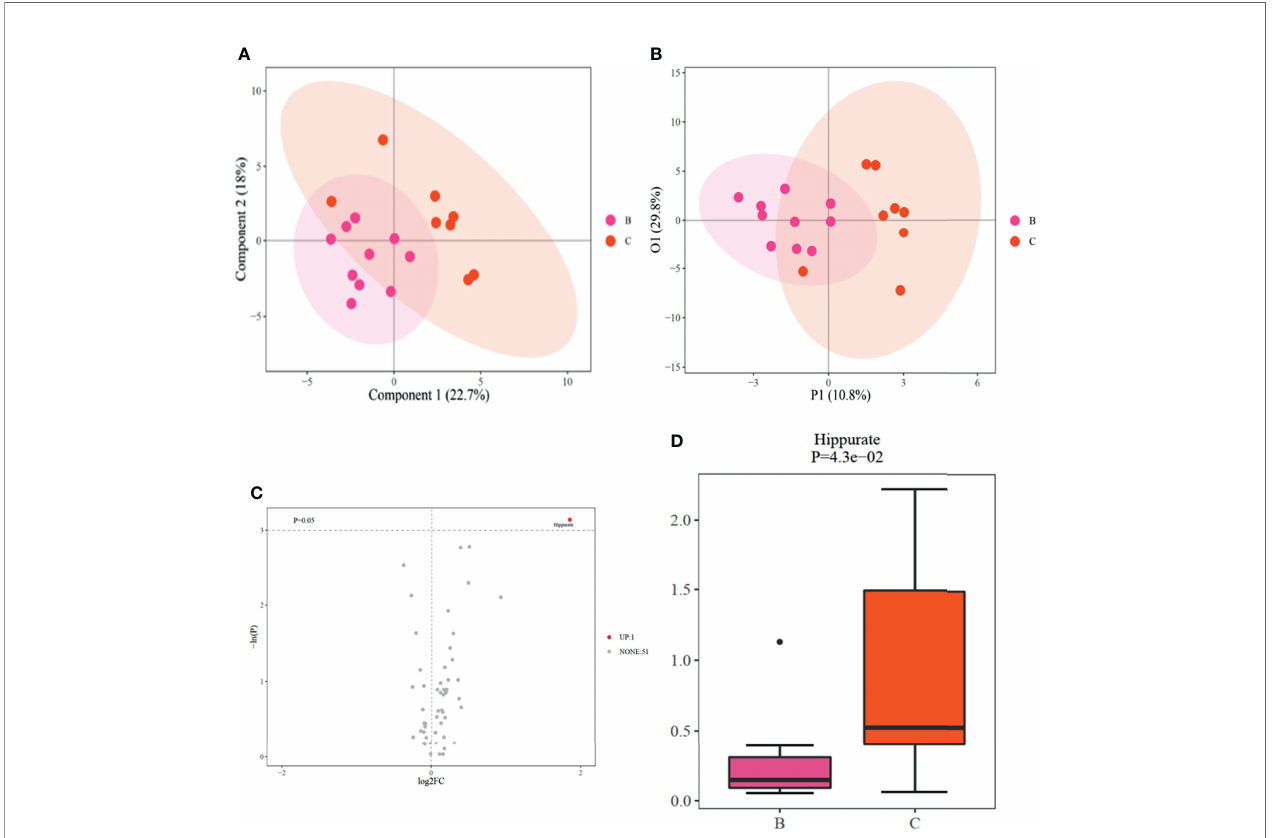
FIGURE 2 | (A). PLSDA scores between OSA non-remission and remission groups at baseline; (B) . OPLS-DA scores between OSA non-remission and remission groups at baseline; (C) . Volcano plot of differential metabolites generated by univariate analysis between OSA non-remission and remission groups at baseline. UP indicates that the level of the metabolite (hippurate) was higher in the OSA non-remission group than the OSA remission group before RYGB surgery. NONE indicates 51 metabolites with no signi fi cant difference between the OSA remission and non-remission groups before RYGB surgery; (D) . Boxplot of hippurate generated by univariate analysis compared between OSA non-remission and remission groups. (B) indicates the OSA remission group and (C) indicates the OSA non-remission group. PLS-DA, partial least squares-discriminant analysis; OPLS-DA, orthogonal partial least squares-discriminant analysis; OSA, obstructive sleep apnea; RYGB, Roux-en-Y gastric bypass